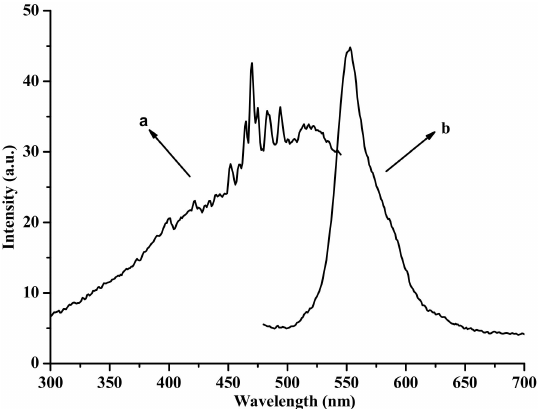
Figure 4. Excitation ( a : λ em = 554 nm) and emission spectra ( b : λ ex = 469 nm) of BPEA in solid